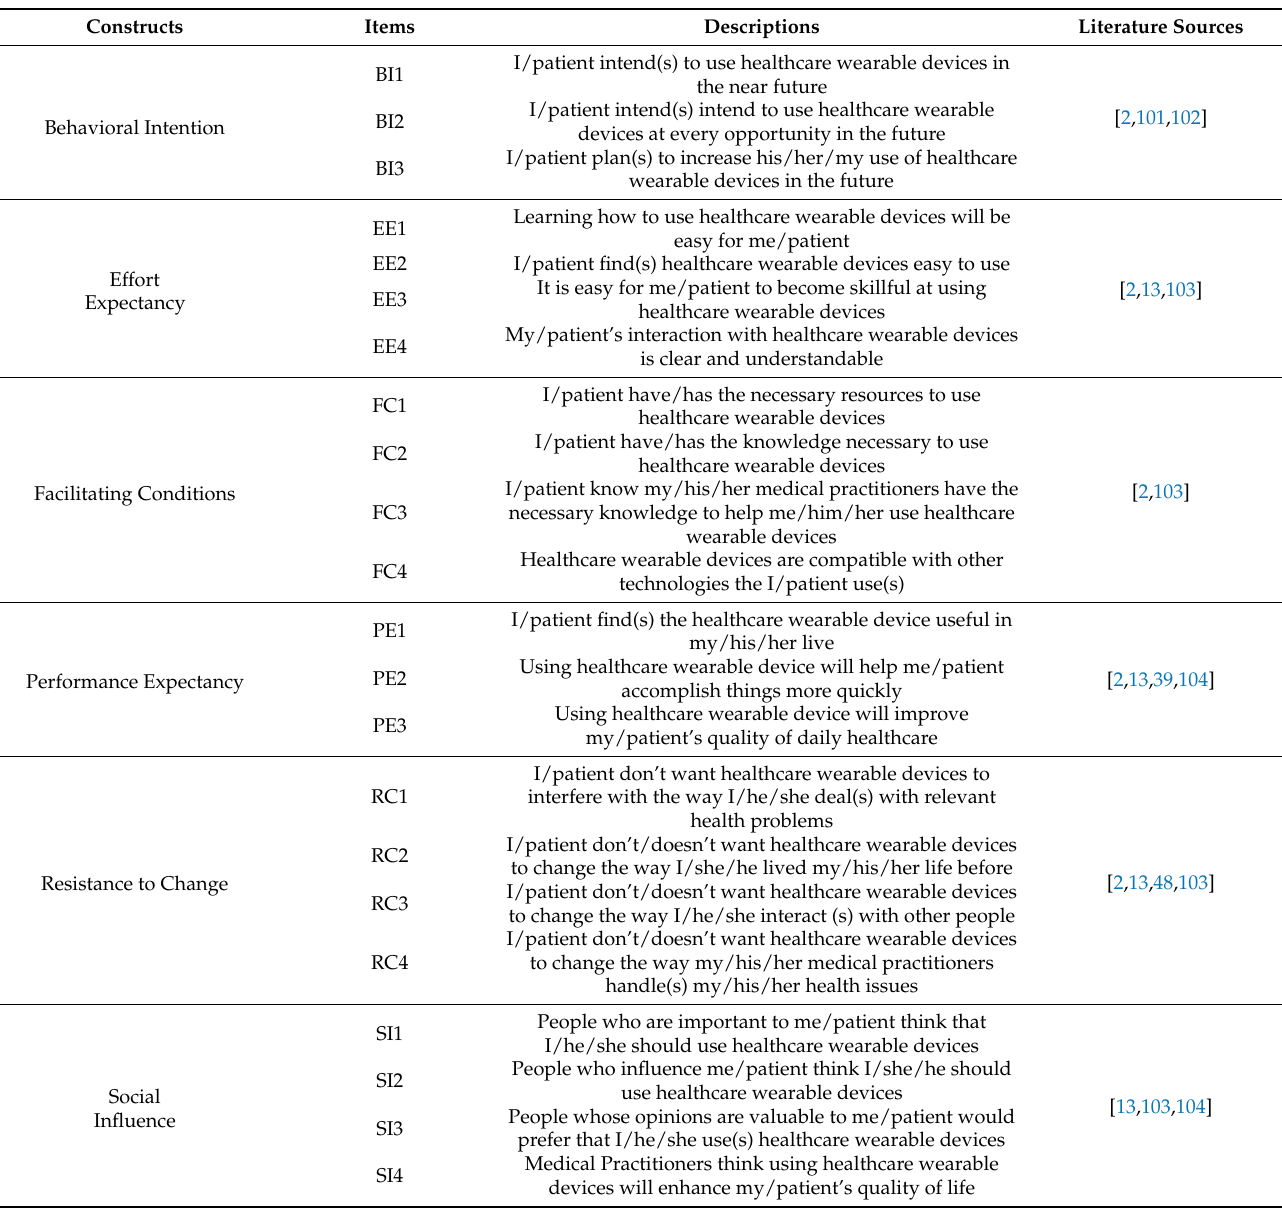
Table A1. Measurement instruments related to the extended UTAUT